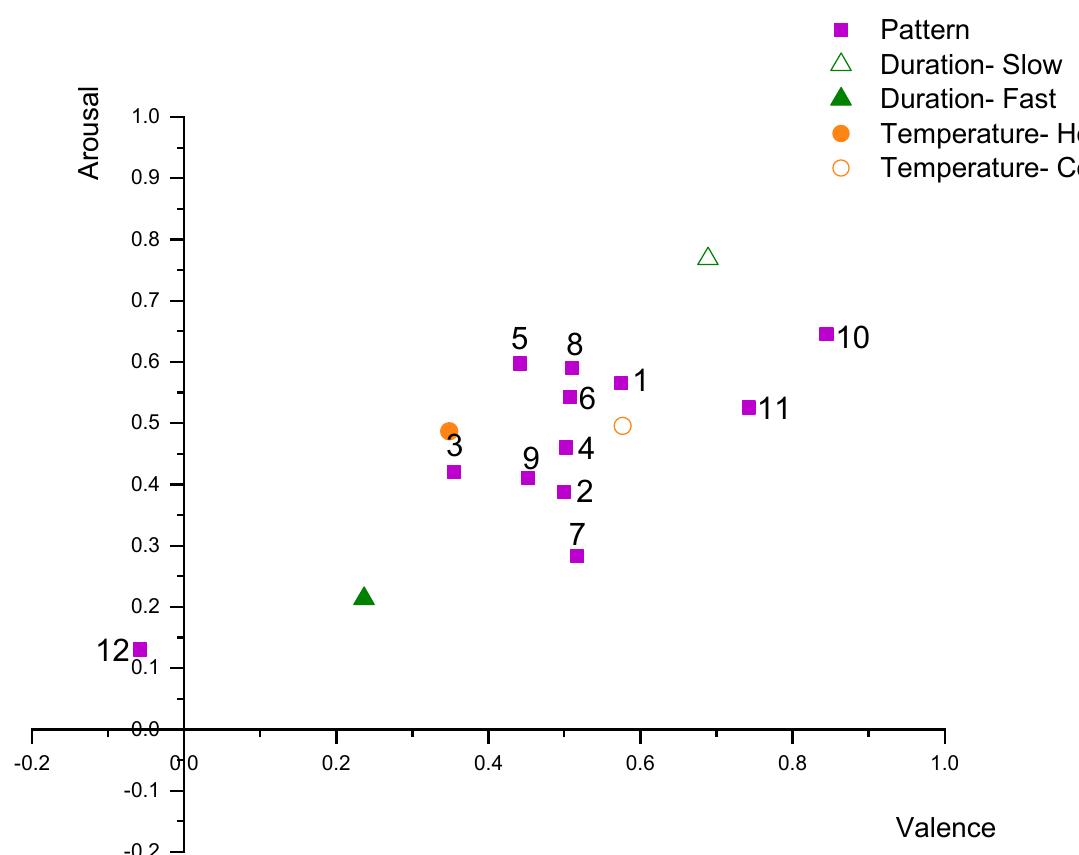
Figure 6. Mean VA scores of emotional responses averaged across each independent factor. The numbers adjoining the Pattern (purple square) datapoints refer to the spatiotemporal pattern type as depicted in Figure 4.